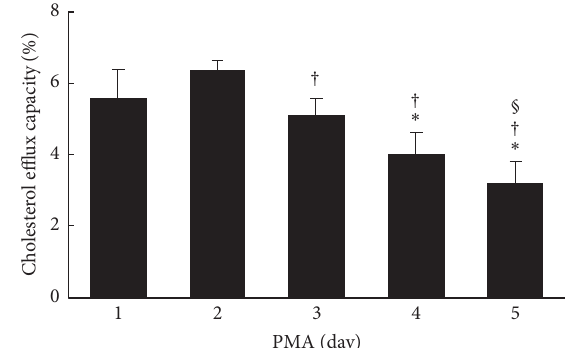
Figure 3: The effect of differentiation on cholesterol efflux capacity of apoA-I. THP-1 cells were treated with 100 ng/mL PMA for different periods (1 to 5 days) and loaded with 3 H-cholesterol (1 𝜇 Ci/mL), acLDL (50 𝜇 g protein/mL), and T0901317 (1 𝜇 mol/L) for 1 day. The cholesterol efflux capacity of apoA-I (10 𝜇 g/mL) was determined under these conditions. The values were indicated by mean + SD ( 𝑛 = 3, ∗ 𝑃 < 0.05 versus day 1, † 𝑃 < 0.05 versus day 2, and § 𝑃 < 0.05 versus day